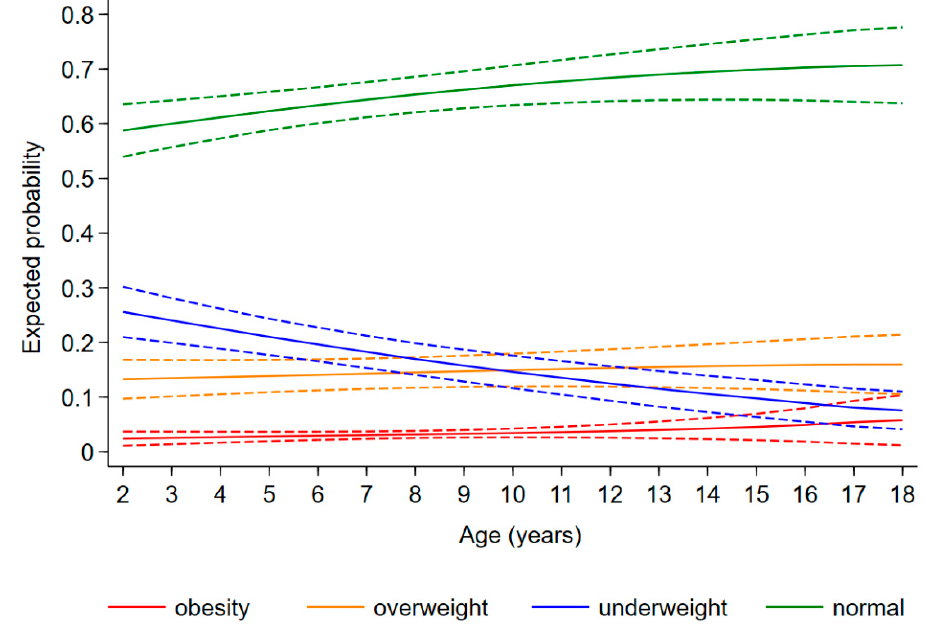
Figure 3. Change in expected probability of underweight (blue), normal weight (green), overweight